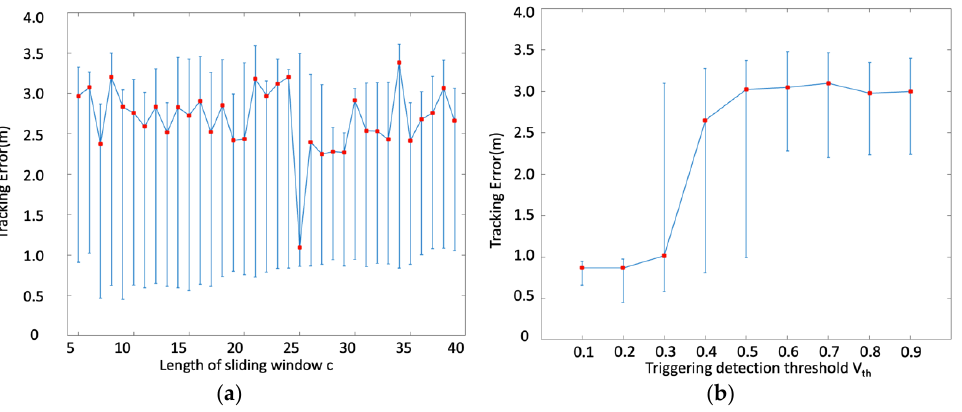
Figure 9. Tracking errors as functions of the length of the sliding window and triggering detection threshold for the conventional GF scheme ( a ) length of sliding window 𝑐 , and ( b ) triggering detection threshold 𝑉 𝑡ℎ . The central marks indicate the medians of tracking errors. The lower and upper bars indicate the 0th and 75th percentiles, respectively.